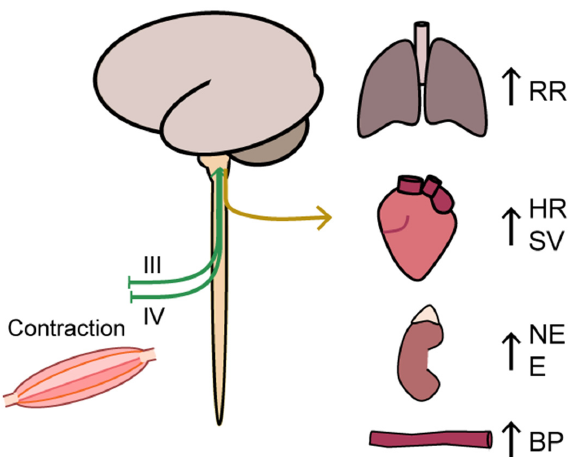
Figure 4. An illustration of the ergoreflex via a central command to the muscle that signals the mus- cle to contract the contraction activates the ergoreflex through mechanoreceptors (group III affer- ents) and metaboreceptors (group IV afferents), which in a feedback manner stimulate autonomic functions and ventilation rate. BP: blood pressure, E: epinephrine, HR: heart rate, NE: norepinephrine, VR: ventilation rate, SV: stroke volume.